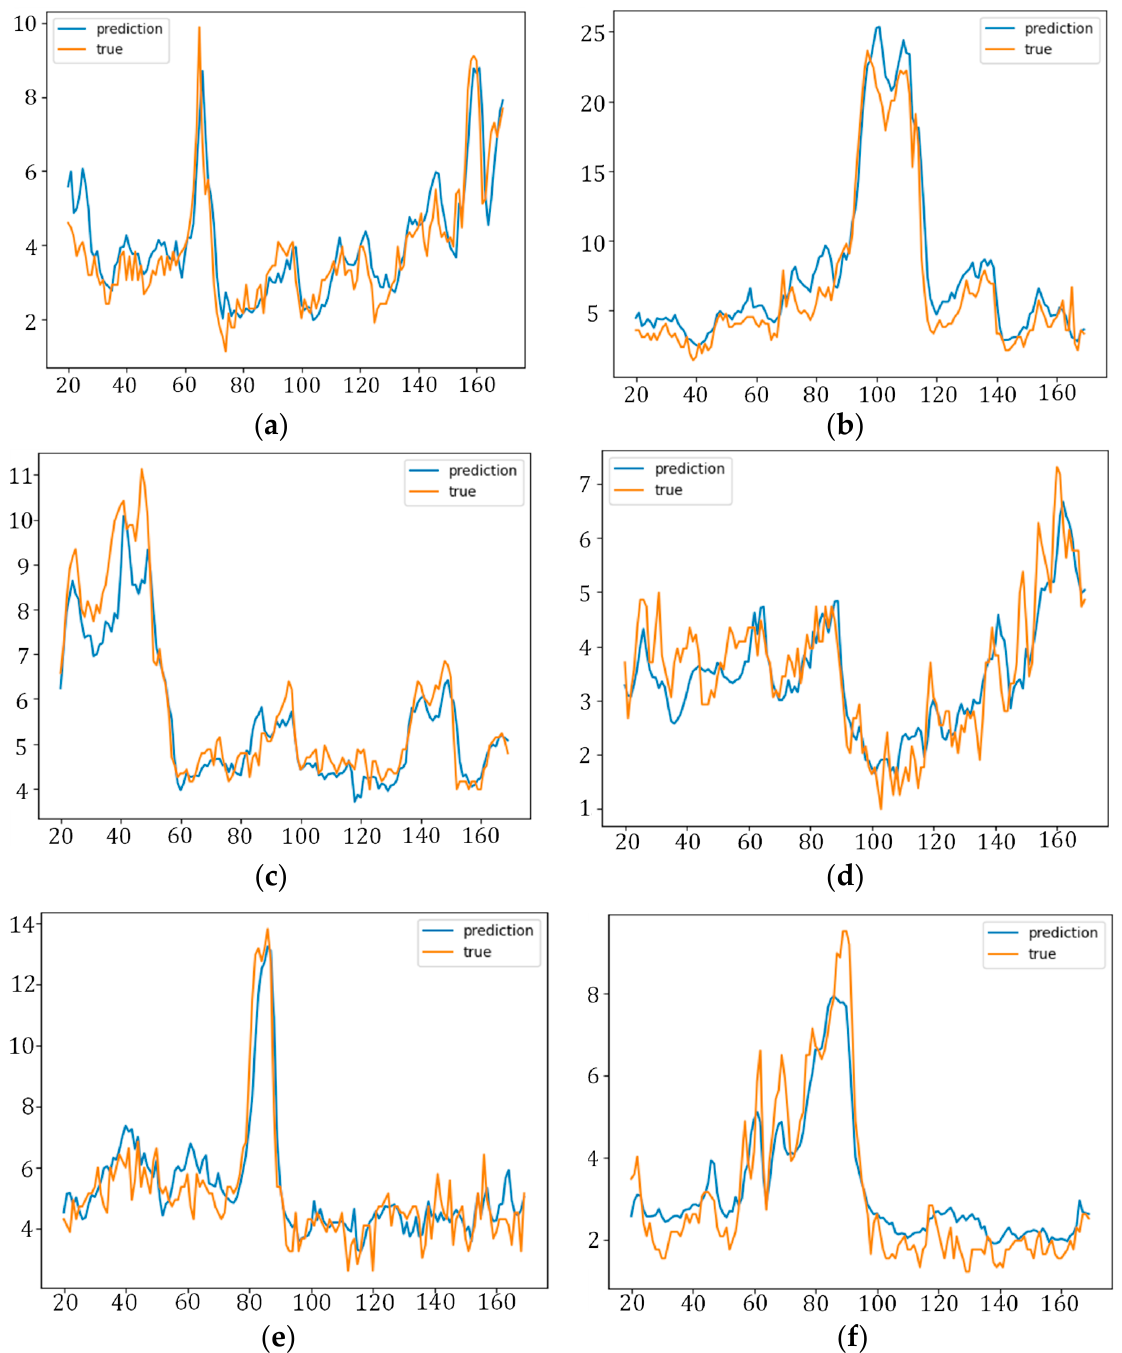
Figure 7. Fi tt ing trends of di ff erent stations: ( a ) Chaunsha; ( b ) Zhangjiang; ( c ) Huinan; ( d ) Pudong; Figure 7. Fitting trends of different stations: ( a ) Chaunsha; ( b ) Zhangjiang; ( c ) Huinan; ( d ) Pudong; ( e ) Zhoupu; ( f ) Lingang. ( e ) Zhoupu; ( f ) Lingang.